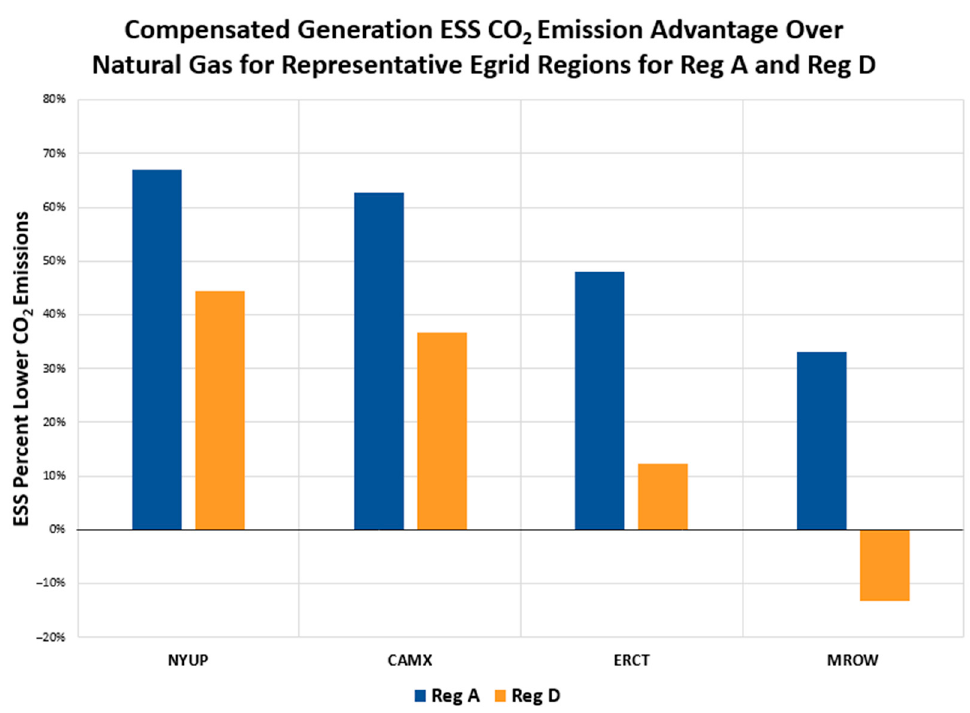
Figure 9. Comparison of the CO 2 emission advantage for ESSs over a natural gas plant providing 20 MW of frequency regulation service using both the Reg A and Reg D signals. The advantage of ESS is reduced when following the Reg D signal. Despite this, the ESS still had lower CO 2 emissions than the natural gas plant in 17 of 22 eGRID subregions under the Reg D signal. Overall, it is important to state that frequency regulation service is not a major con ‐ tributor to emissions. Currently, the PJM Regional Transmission Operator (RTO) from